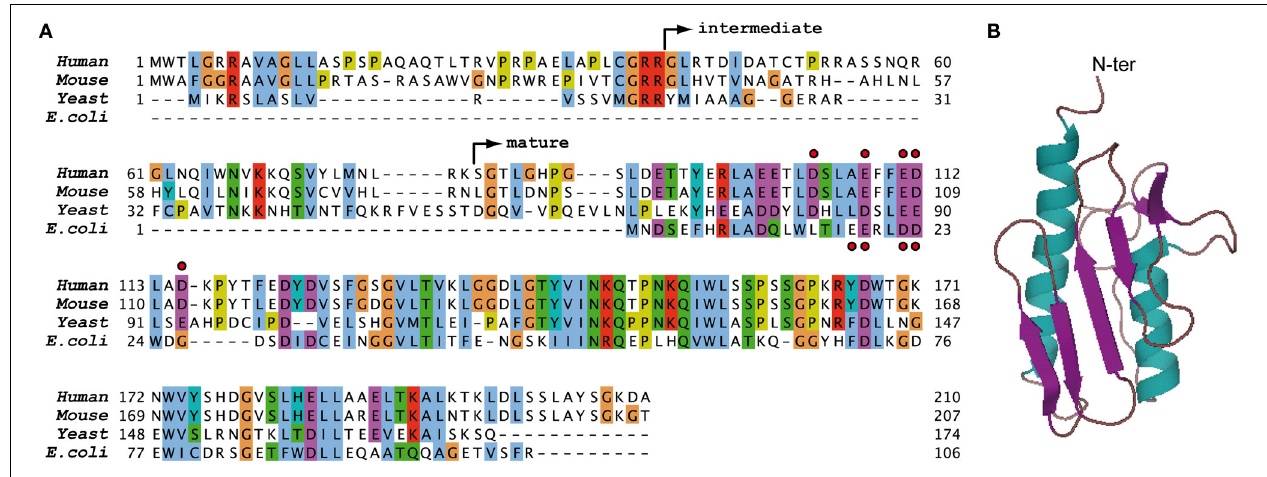
FIGURE 1 | Sequences and structure of frataxin. (A) Sequence alignment of human, mouse, yeast, and bacterial frataxin. The non-conserved N-terminal parts of human, mouse, and yeast frataxins contain the mitochondrial targeting sequence of the protein. The arrows indicate the intermediate and mature forms of human FXN that are obtained during the